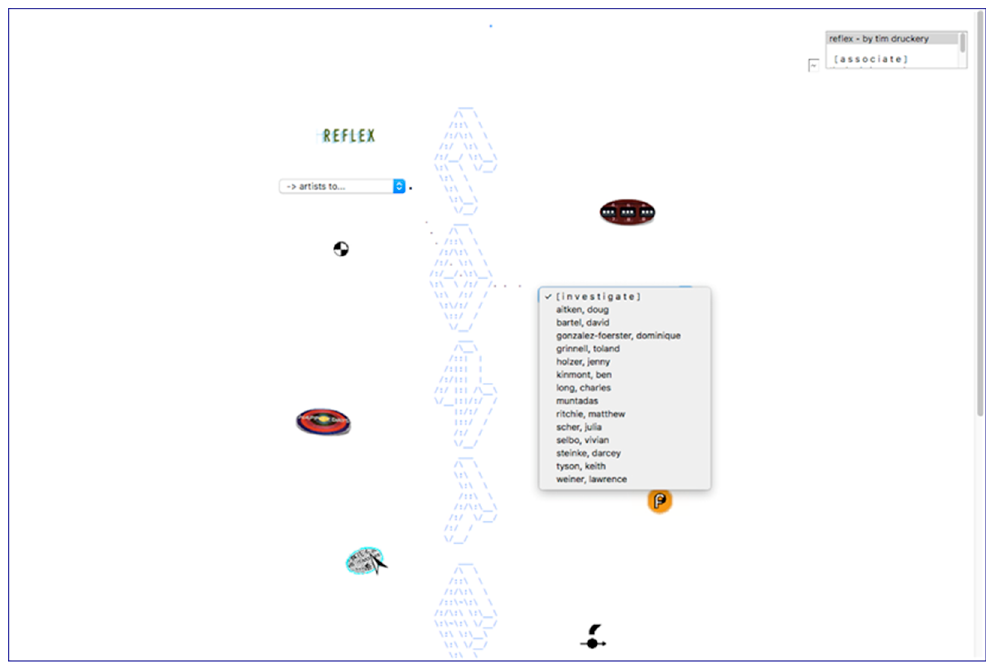
Figure 2. äda’web—context section, 1995. Screenshot of index page, 2019. © äda’web.